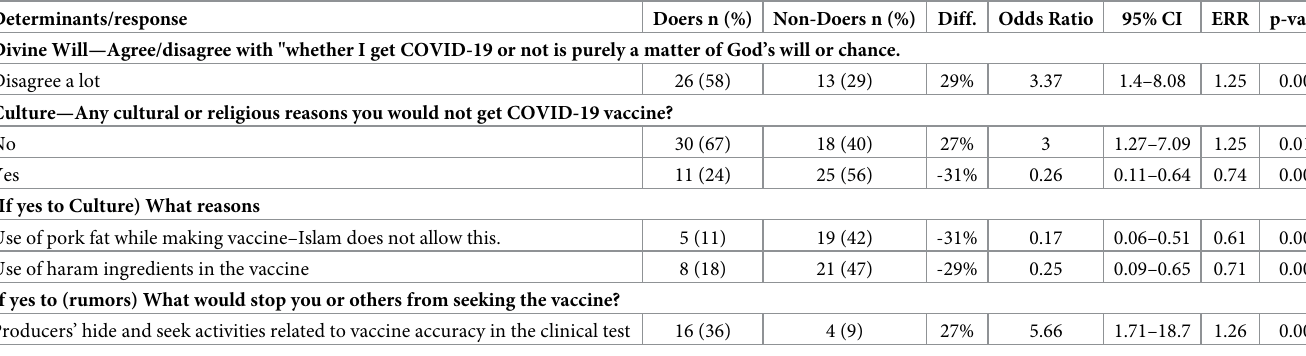
Table 8. Perceived divine will and